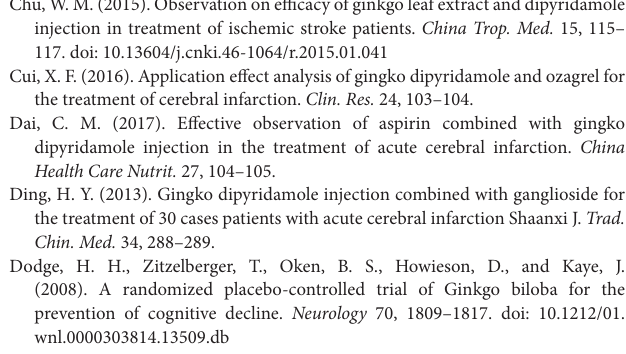
SUPPLEMENtARy FIGURE 1 | Sensitivity Analysis for National Institutes of Health Stroke Scale (NIHSS). SUPPLEMENtARy FIGURE 2 | Forest plot of the comparison of plasma C reactive protein (CRP) between the experimental and control group. Control group, conventional treatments alone group; Experimental group, conventional treatments and GDI combined group. GDI, Ginkgo leaf extract and dipyridamole injection. The random effects meta-analysis model (Inverse Variance method) was used. SUPPLEMENtARy FIGURE 3 | Forest plot of the comparison of the hemorrheology indexes including WBV (A) , PV (B) , WBHSV (C) , WBLSV (D) and FIB (E) between the experimental and control group. Control group, conventional treatments alone group; Experimental group, conventional treatments and GDI combined group. WBV, whole blood viscosity; PV, plasma viscosity; WBHSV, whole blood high-shear viscosity; WBLSV, whole blood low-shear viscosity; FIB, content of fibrinogen; GDI, Ginkgo leaf extract and dipyridamole injection. SUPPLEMENtARy FIGURE 4 | Forest plot of the comparison of the blood lipid indexes including TC (A) , TG (B) , HDL-C (C) and LDL-C (D) between the experimental and control group. Control group, conventional treatments alone group; Experimental group, conventional treatments and GDI combined group. TC, plasma total cholesterol; TG, triglycerides; HDL-C, high density lipoprotein- cholesterol; LDL-C, low density lipoprotein-cholesterol; GDI, Ginkgo leaf extract and dipyridamole